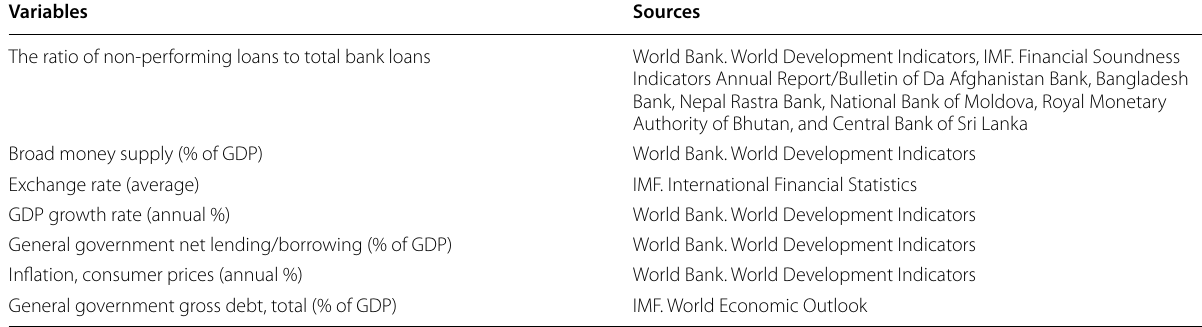
Table 10 Individual data